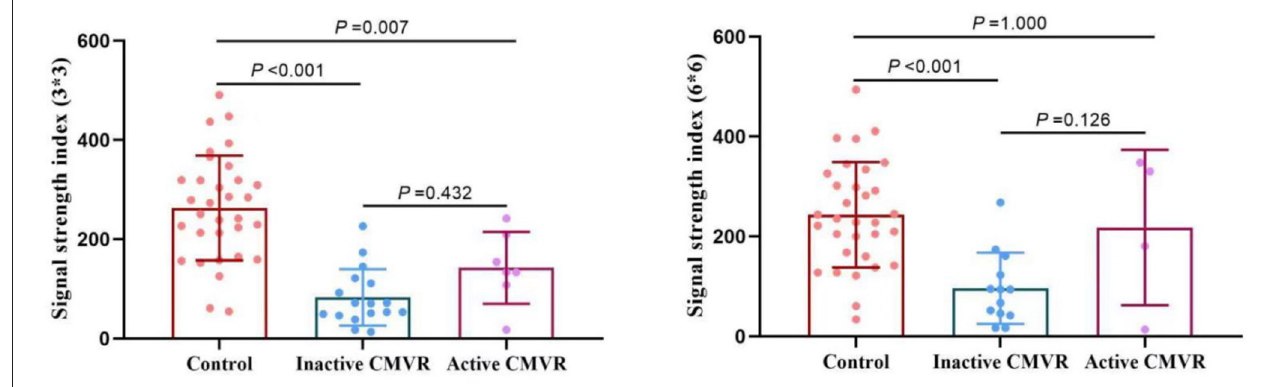
FIGURE 3 | Comparison of the signal strength in the 3 × 3mm (left) and 6 × 6mm (right) scan patterns between groups.